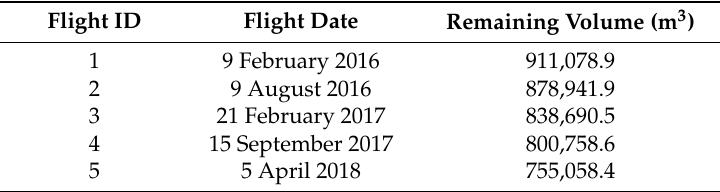
Figure 7. ( a ) Theory of volumetric calculations for the remaining volume; ( b ) 3D visualization of the volumetric calculation.